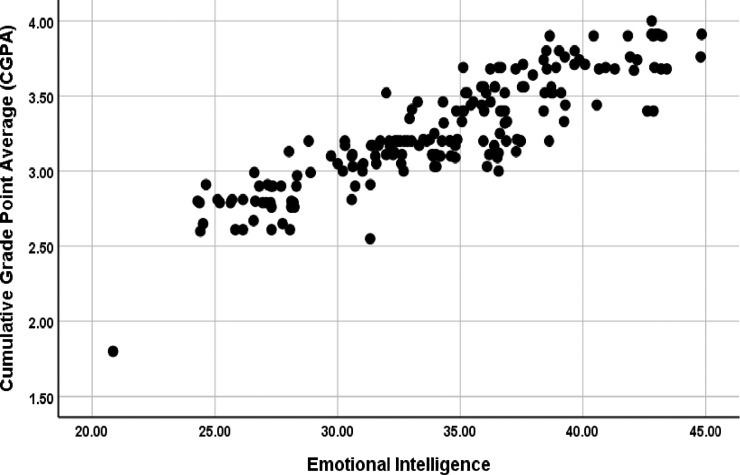
Correlation between emotional intelligence and academic success.The scatterplot clearly shows a significant positive relationship between emotional intelligence and academic success in terms of Cumulative Grade Points Average (CGPA) among undergraduate students of KUST.